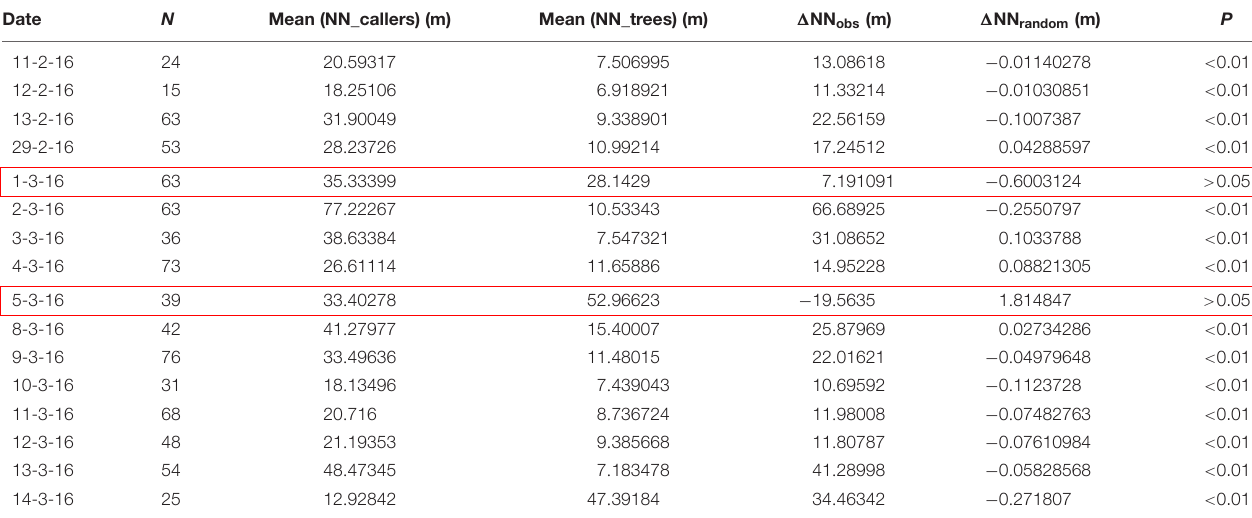
Figure 2 . A total of 172 calling males were located in the study area. A visual comparison of the distribution of nearest neighbour (NN) distances of trees and that of callers revealed that the NN distances of callers were on average greater than of trees ( Figure 1B ). This suggests that calling males are dispersing and spacing out more than would be expected if they were to occupy trees randomly. To statistically test for overdispersion of calling males, data were pooled across nights and the spatial distributions ( Figure 1C ). Callers were found to be spacing themselves apart since the observed difference between the mean NN distances of callers and of trees was found to be significantly higher than the expected difference if the callers were to distribute themselves randomly with respect to trees ( Figure 1C ).